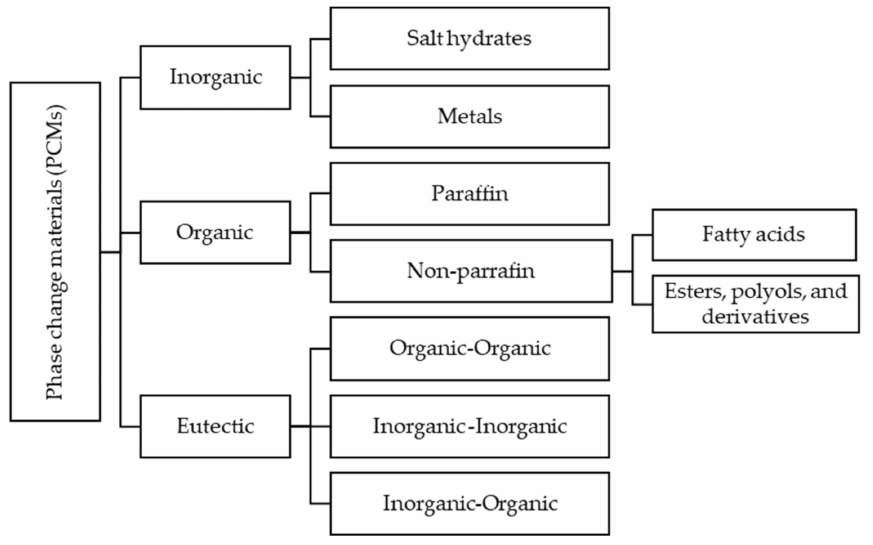
Figure 2. PCMs classification